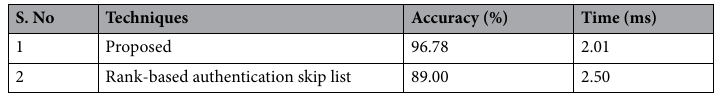
Table 1. Comparison of proposed and existing methods interms of accuracy and